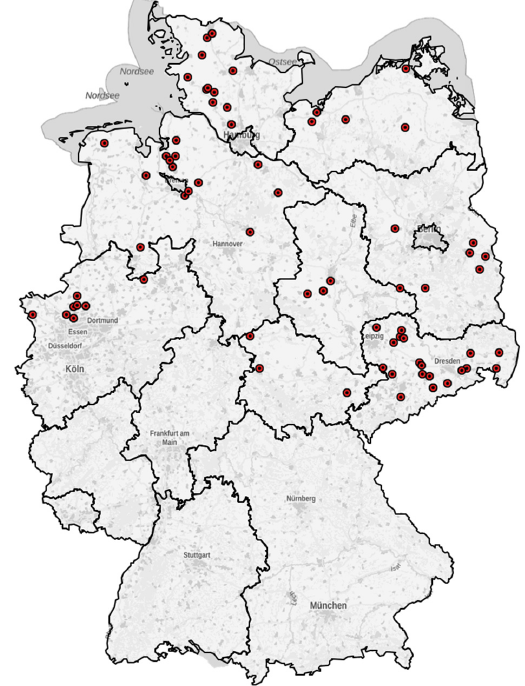
Figure 1. Map of Germany with the localizations of the farms that participated in the study. Each point ( • ) represents one